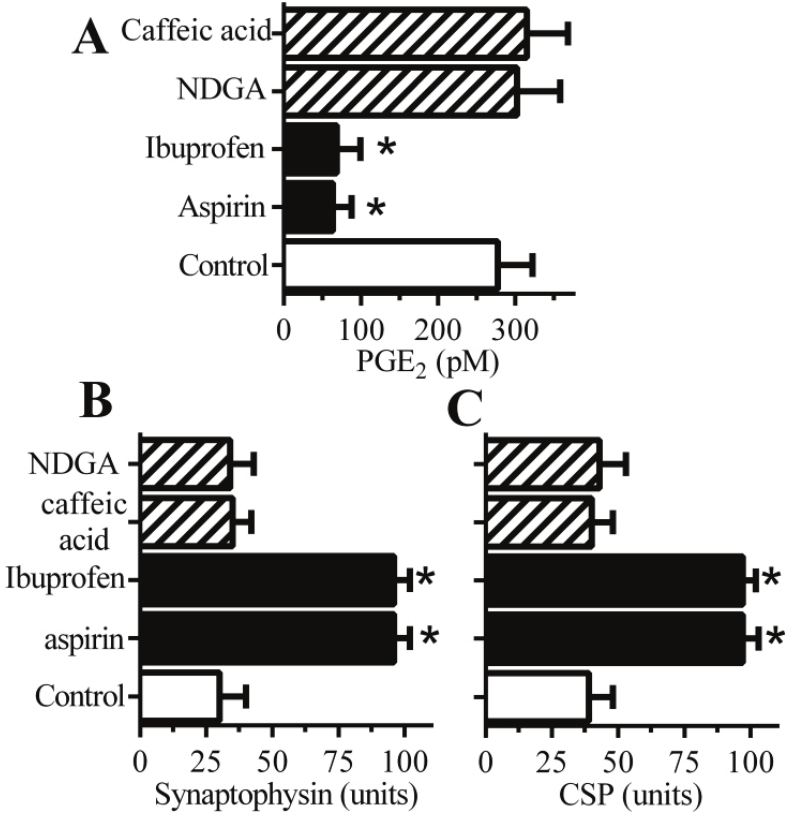
Figure 3. Cyclooxygenase inhibitors protect neurons against (cid:2)SN-induced synapse damage. ( A ) The concentrations of PGE 2 produced by synaptosomes pre-treated with a vehicle control ((cid:6)), cyclooxygenase inhibitors (aspirin and ibuprofen) ((cid:7)) or lipoxygenase inhibitors (caffeic acid and nordihydroguaiaretic acid (NDGA)) (striped bars) and incubated with 500 nM (cid:2)SN. Values are means ± SD from triplicate experiments performed three times, n = 9. * = significantly lower than control synaptosomes incubated with 500 nM (cid:2)SN. The amounts of synaptophysin ( B ) and CSP ( C ) in neurons pre-treated with a vehicle control ((cid:6)), cyclooxygenase inhibitors (aspirin and ibuprofen) ((cid:7)) or lipoxygenase inhibitors (caffeic acid and NDGA) (striped bars) and incubated with 1 (cid:8)M (cid:2)SN. Values are means ± SD from triplicate experiments performed four times, n = 12. * = significantly higher than in control neurons incubated with